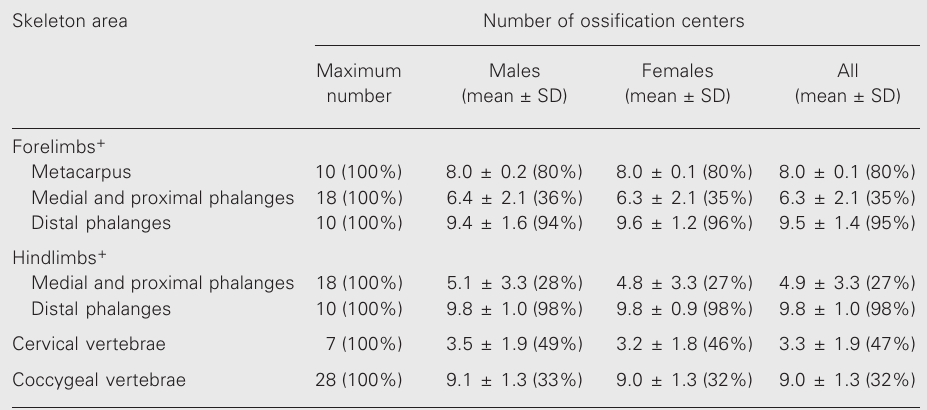
Table 4. Extent of skeleton ossification of male and female rat fetuses on pregnancy day